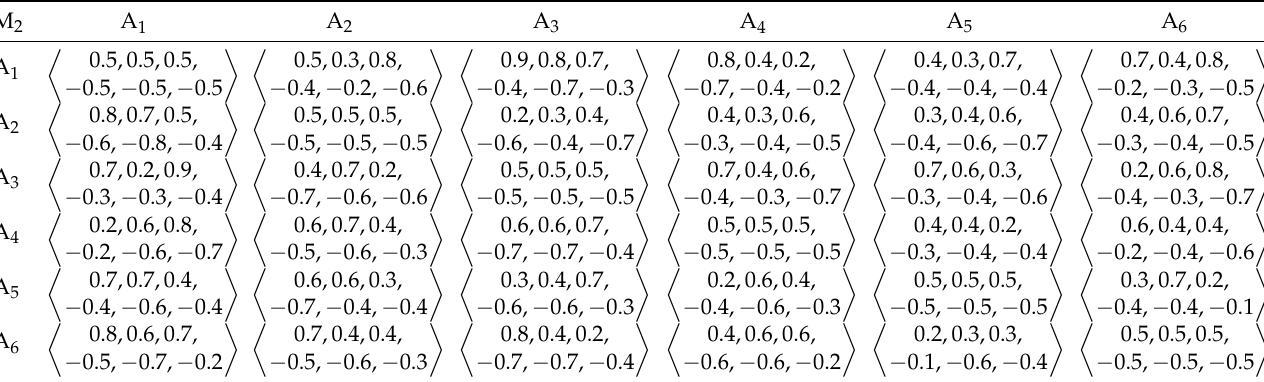
Table 9. BSVNPR of the expert from the engineering management